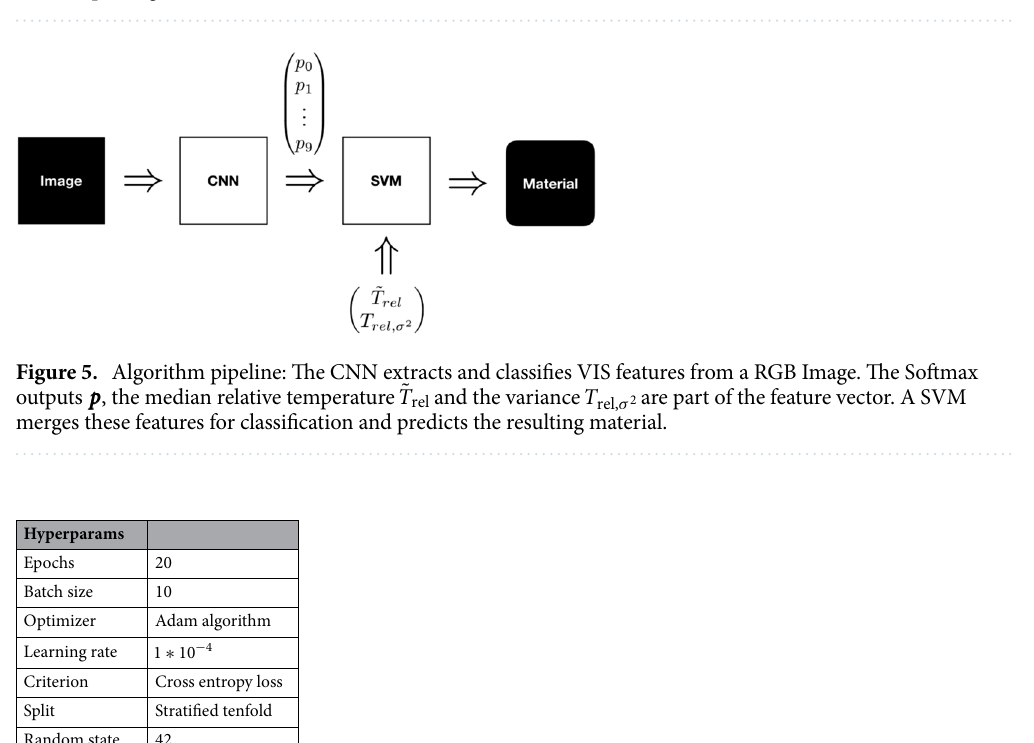
Figure 4. Histograms of the convergence analysis: To evaluate whether the algorithm converges, one experiment was done 1,000 times with a constant train test split (left) and another with 10 times in a stratified tenfold split (right).